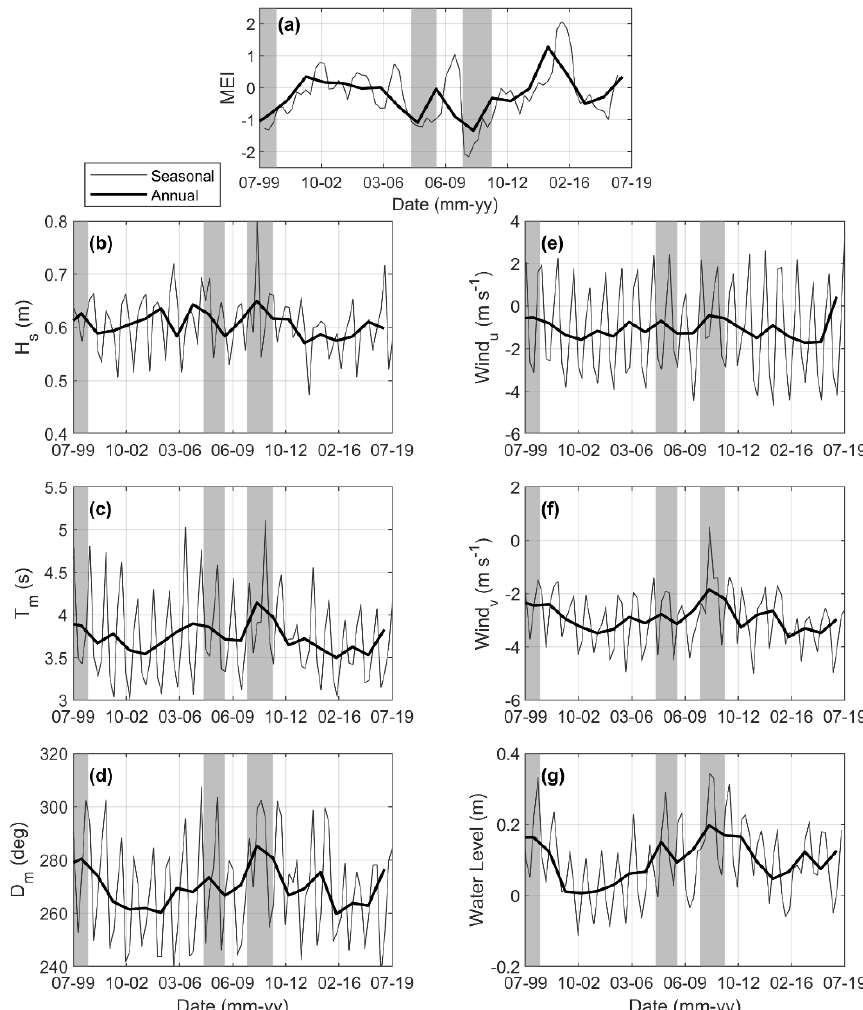
Figure 2. Seasonal (dark grey) and annual averaged (black line): ( a ) Multivariate El Niño Southern Oscillation (ENSO) Index (MEI), ( b ) significant wave height, ( c ) mean wave period, ( d ) mean wave direction, ( e ) easterly wind component, ( f ) northerly wind component, and ( g ) water level in Exmouth Gulf from 1999–2019. Wave and wind variables ( b – f ) were derived from our hindcast model (white asterisk in Figure 1); water level data are from the Exmouth tide gauge maintained by the Western Australia Department of Transport. In all panels, grey shading denotes La Niña events, classified as periods when MEI was less than −